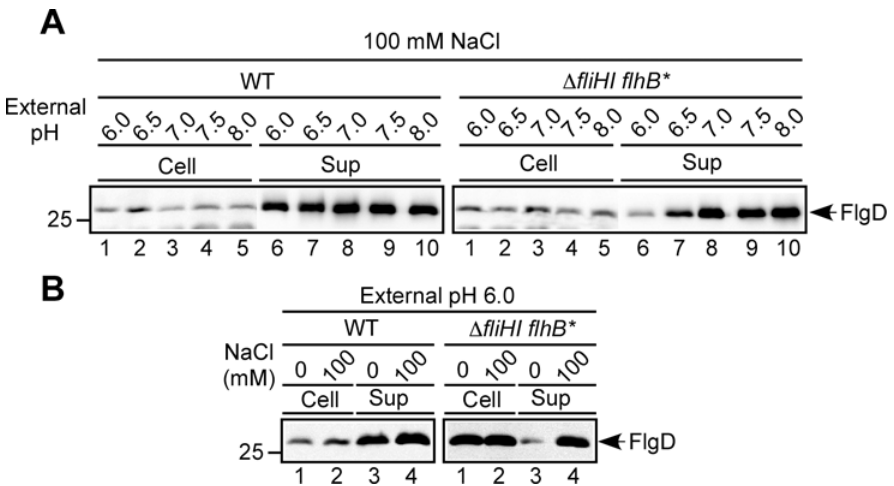
Fig 4. Effect of external pH change on Na + -dependent flagellar protein export. (A) Effect of external pH change on FlgD secretion. Immunoblotting, using polyclonal anti-FlgD antibody, of whole cell proteins (Cells) and culture supernatant fractions (Sup) prepared from SJW1103 (WT) and MMHIJ0117 ( Δ fliHIJ flhB * ) grown at 30°C in T-broth containing 100 mM NaCl at an external pH value of 6.0, 6.5, 7.0, 7.5 or 8.0. (B) Effect of external Na + on FlgD secretion at external pH 6.0. Immunoblotting, using polyclonal anti-FlgD antibody, of whole cell proteins and culture supernatant fractions prepared from SJW1103 (WT) and MMHI0117 ( Δ fliHI flhB * ) grown exponentially at 30°C in T-broth with or without 100 mM NaCl at external pH